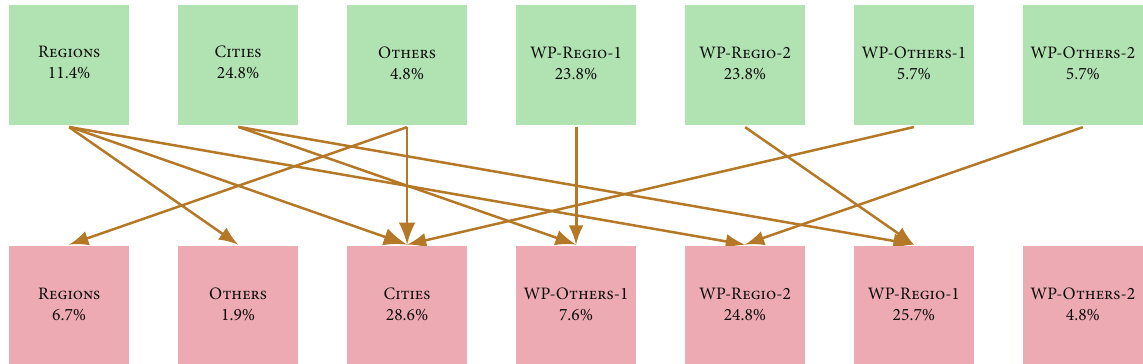
Figure 21: Error analysis regarding the classification of TTNs by means of cos